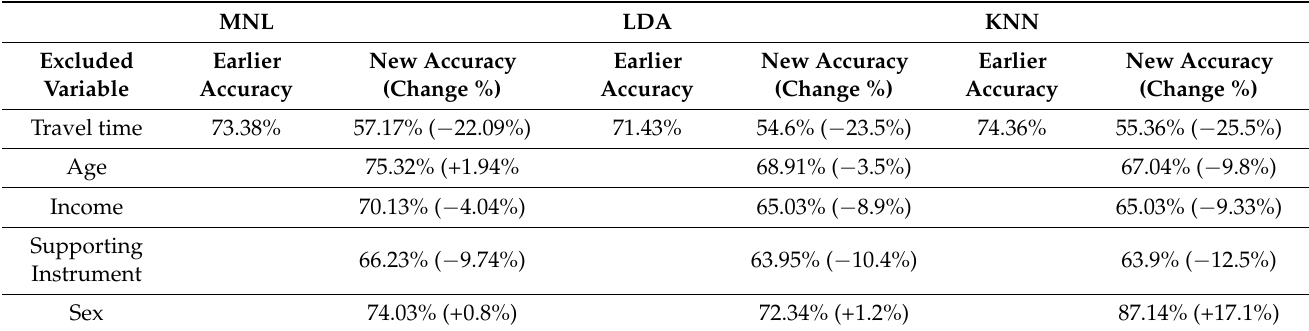
Table 8. Change in accuracy with the exclusion of